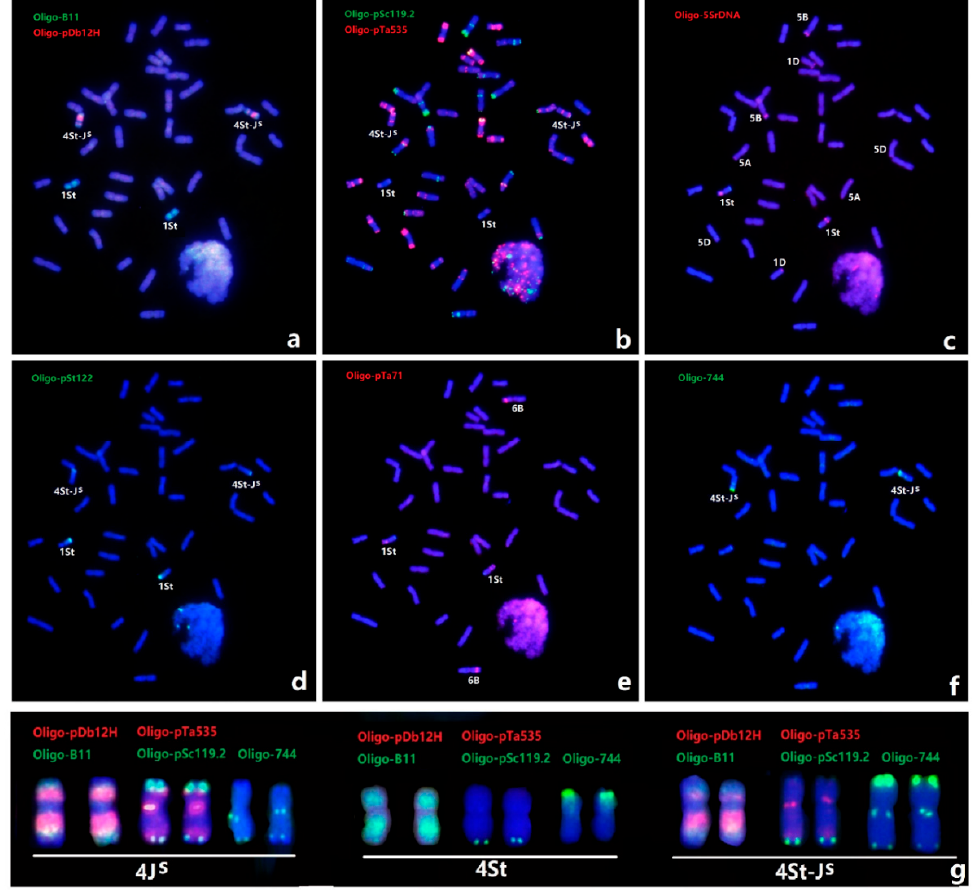
Figure 1. Sequential ND-FISH patterns of wheat- Th. intermedium double substitution line, X479. The probes for FISH are: ( a ) Oligo-B11 (green) and Oligo-pDb12H (red); ( b ) Oligo-pSc119.2 (green) and Oligo-pTa535 (red), ( c ) Oligo-5SrDNA; ( d ) Oligo-pSt122; ( e ) Oligo-pTa71; and ( f ) Oligo-744 (green). The karyotype of the 4J S , 4St and 4St-J S chromosomes are shown using the probe combinations Oligo-B11 with Oligo-pDb12H (left), Oligo-pSc119.2 and Oligo-pTa535 (middle), and Oligo-744 (right), respectively ( g ).